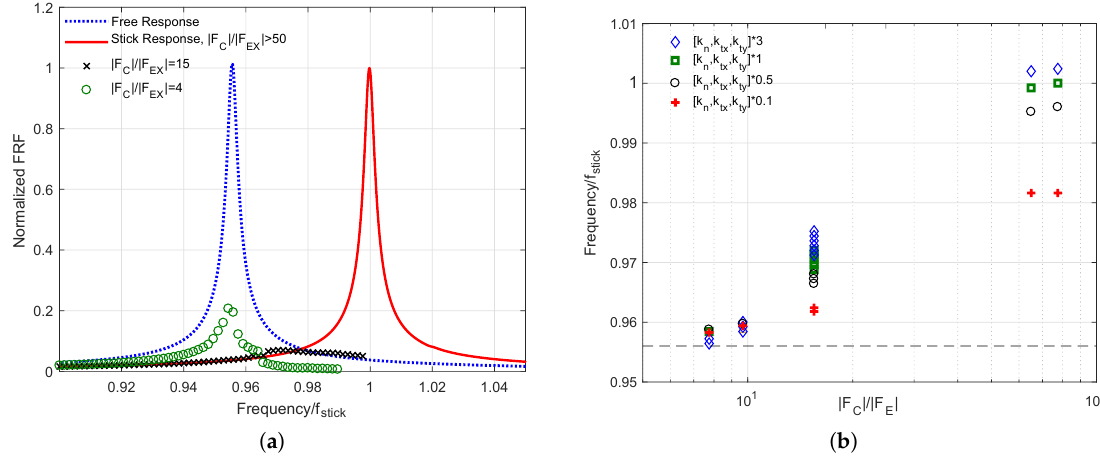
Figure 4. ( a ) Example of Free, Full Stick and Nonlinear forced response of the blade-strip system. ( b ) Resonance frequency values as a function of the excitation level | F c | / | F ex | . For | F c | / | F ex | = 15, the peak is flat and multiple values are plotted in the figure to reflect this